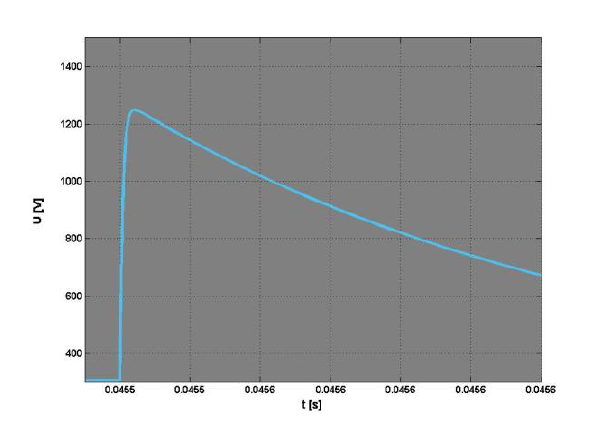
Fig. 2. The course of the voltage signal on the receiver